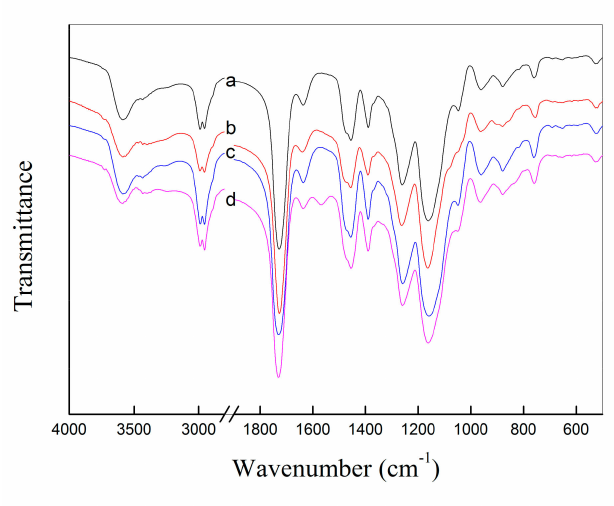
Figure 2. FTIR spectra of ( a ) haa-MIP, ( b ) MIP-PHEMA, ( c ) MIP-PIA, ( d )